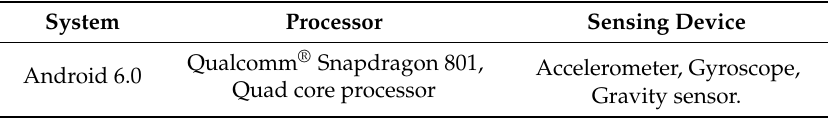
Table 2. Specifications of the experimental mobile